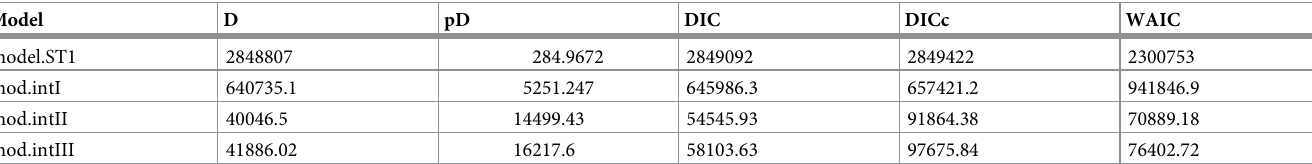
Table 2. Comparison of models basing on DIC and